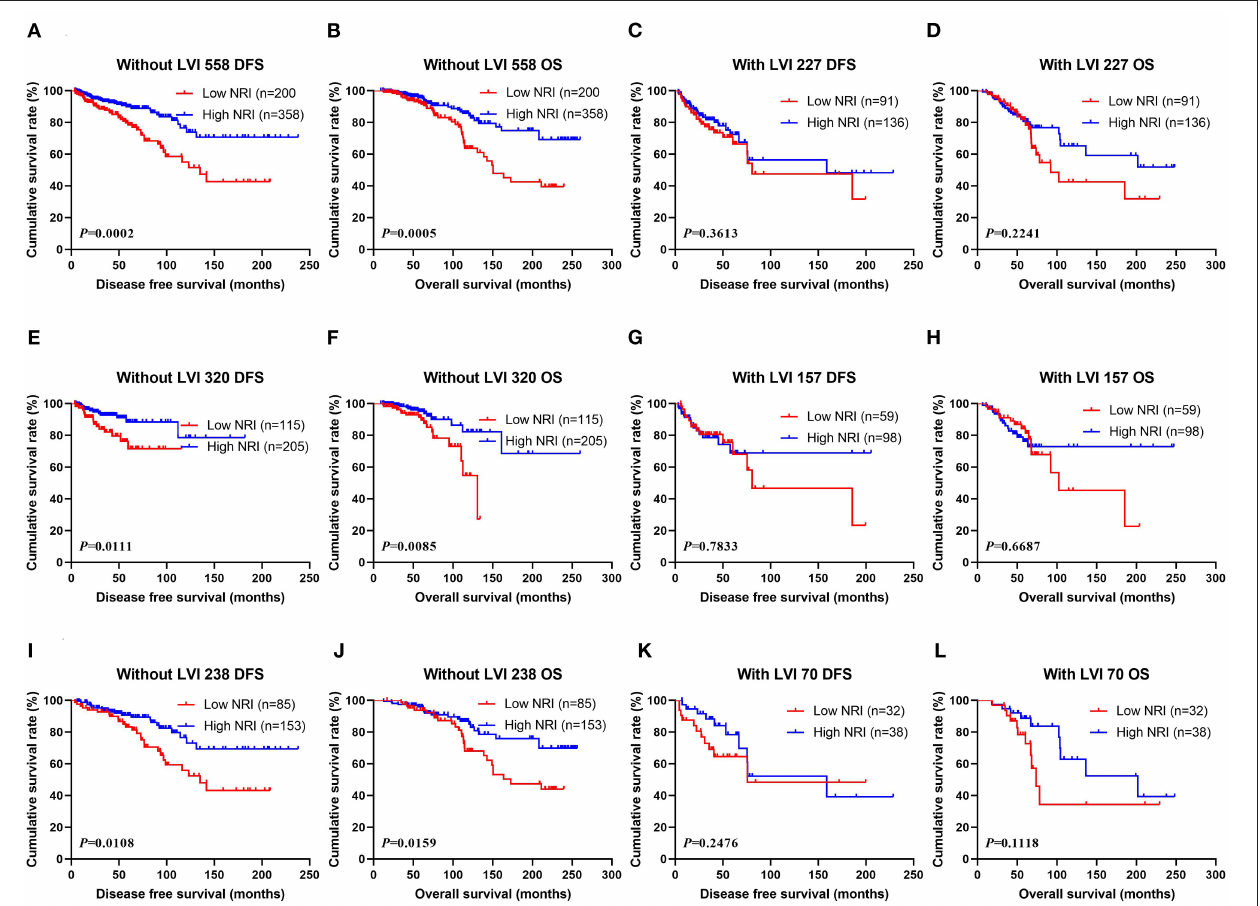
FIGURE 4 | (A) Kaplan-Meier analysis of DFS of patients without LVI by NRI in all breast cancer patients, (B) Kaplan-Meier analysis of OS of patients without LVI by NRI in all breast cancer patients, (C) Kaplan-Meier analysis of DFS of patients with LVI by NRI in all breast cancer patients, (D) Kaplan-Meier analysis of OS of patients LVI by NRI in all breast cancer patients; (E) Kaplan-Meier analysis of DFS of patients without LVI by NRI in NACT group, (F) Kaplan-Meier analysis of OS of patients without LVI by NRI in NACT group, (G) Kaplan-Meier analysis of DFS of patients with LVI by NRI in NACT group, (H) Kaplan-Meier analysis of OS of patients with LVI by NRI in NACT group; (I) Kaplan-Meier analysis of DFS of patients without LVI by NRI in non-NACT group, (J) Kaplan-Meier analysis of OS of patients without LVI by NRI in non-NACT group, (K) Kaplan-Meier analysis of DFS of patients with LVI by NRI in non-NACT group, (L) Kaplan-Meier analysis of OS of patients with LVI by NRI in non-NACT